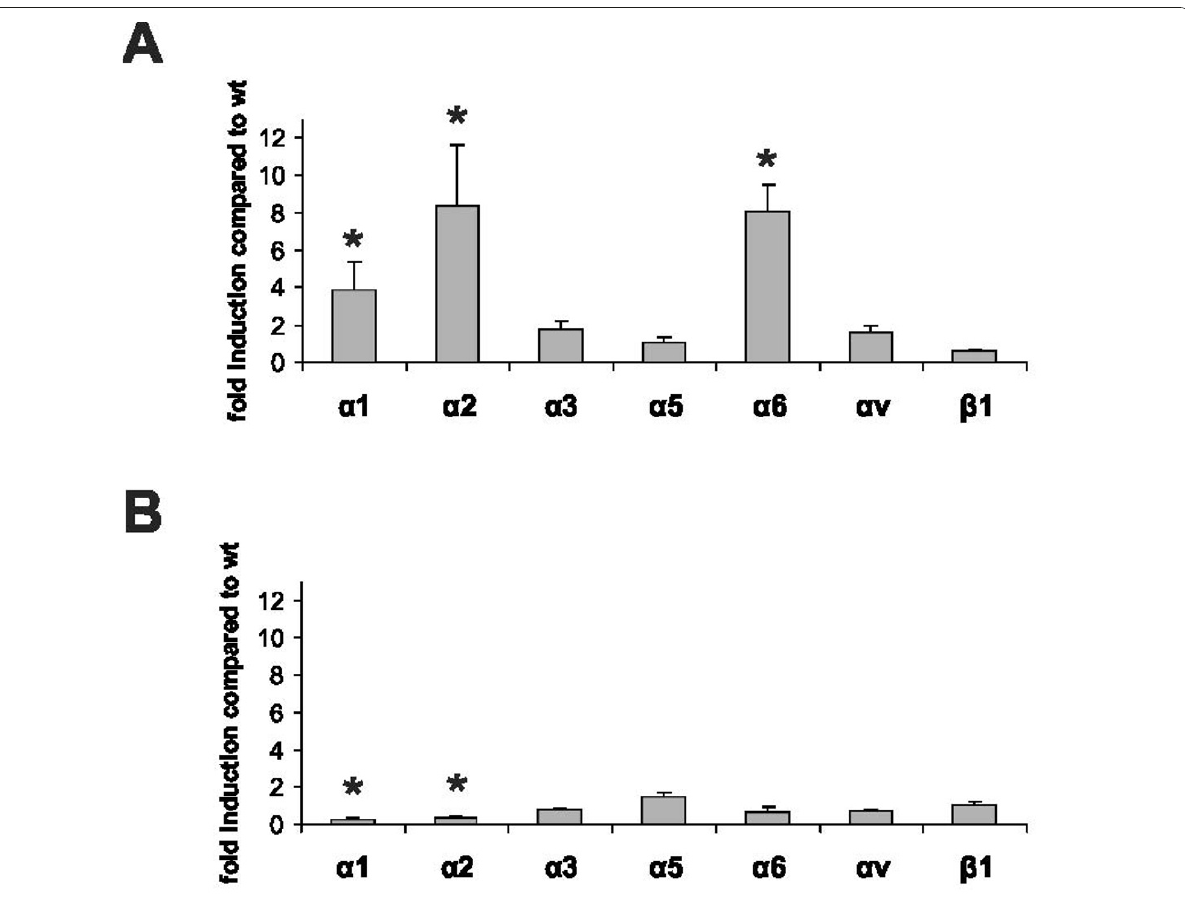
Figure 8 Real-time RT-PCR analysis of integrin chain a 1, a 2, a 3, a 5, a 6, a v and b 1 expression profiles in wild type (wt) and a 8 integrin-deficient ( a 8-/-) mesangial cells (A) and freshly isolated vascular smooth muscle cells (B) . Results are representative for at least 3 similar experiments. Data are means ± sd. * p < 0.05 vs.